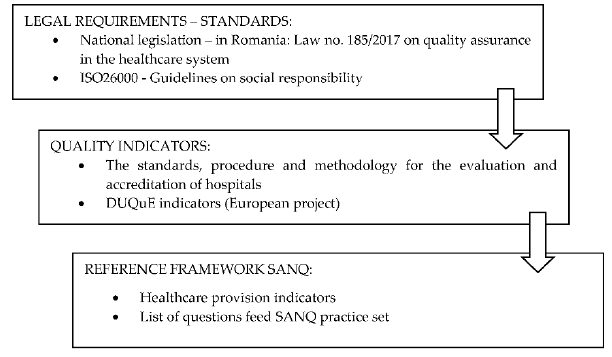
Figure 1. SANQ framework conceptual model.